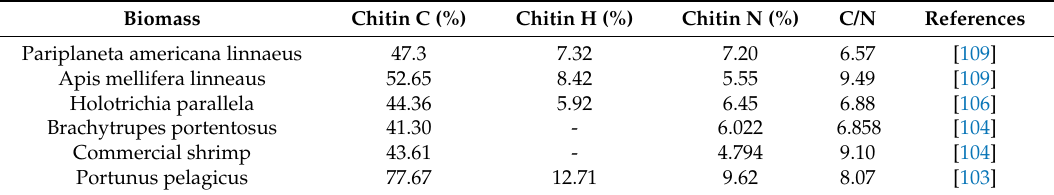
Table 6. Elemental compositions of chitin obtained from different animal-based biomasses (in dry weight %